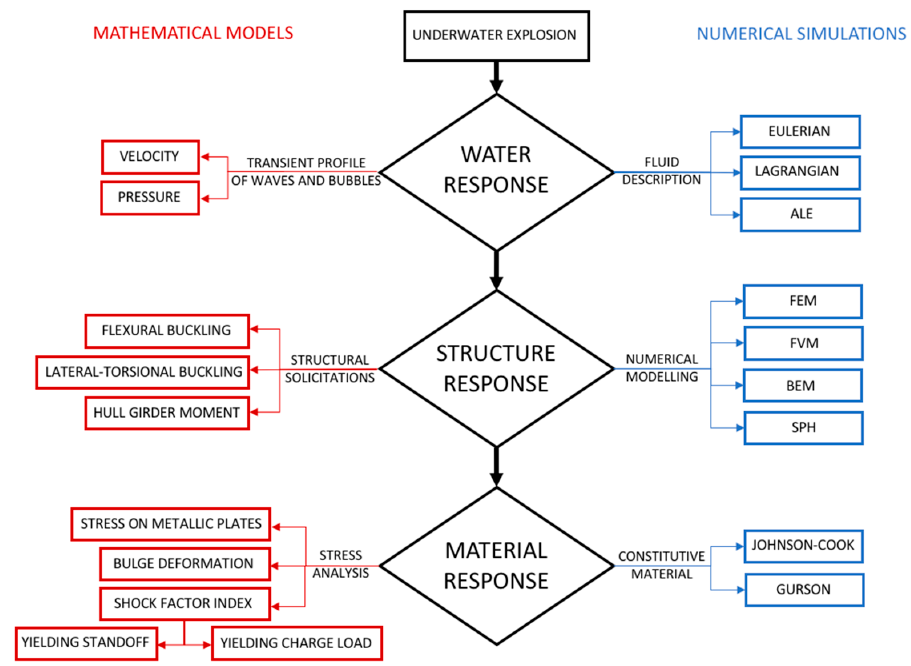
Figure 1. Flow chart scheme of UNDEX aspects approached in the present work.